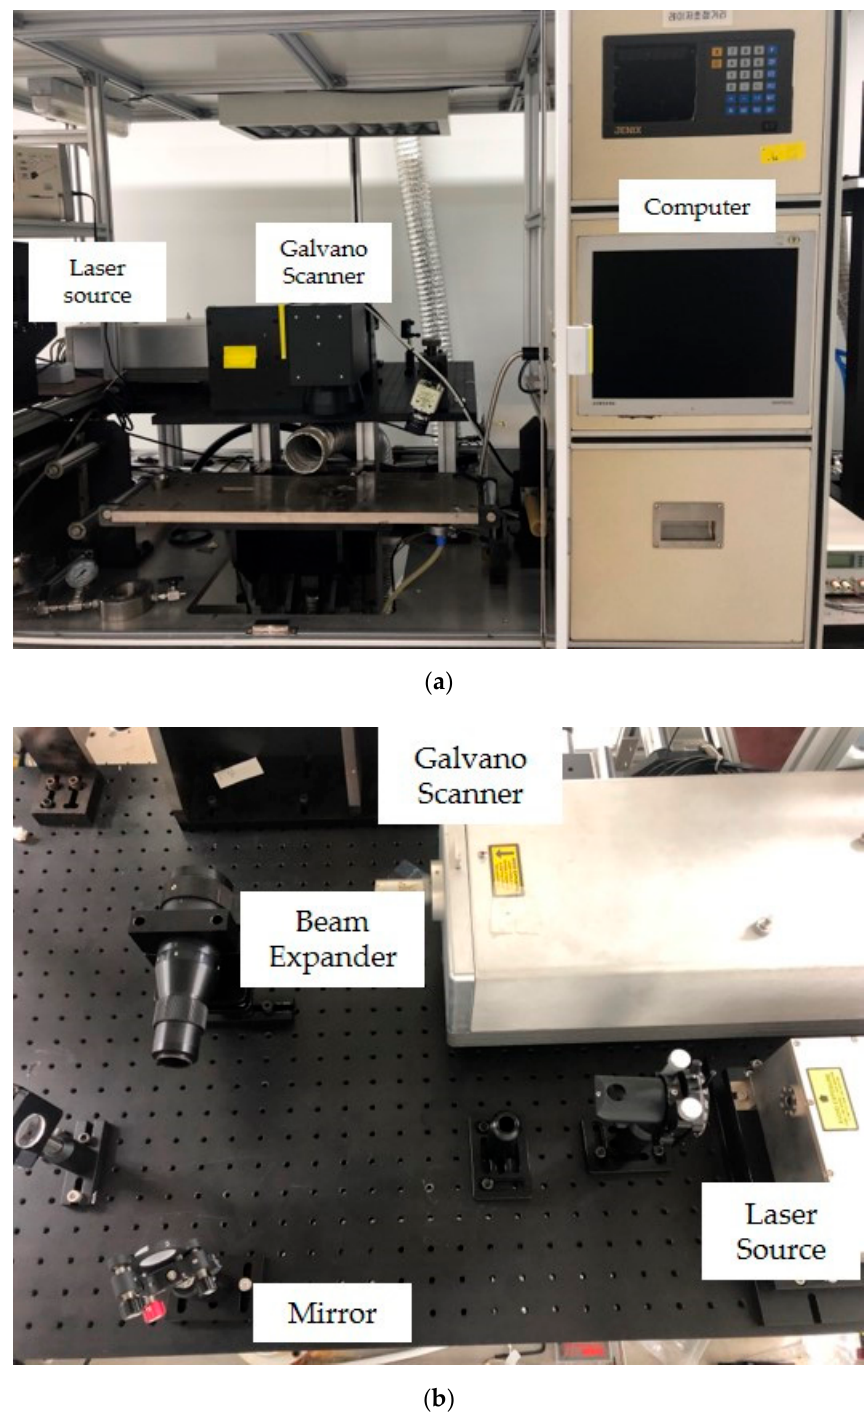
Figure 1. Laser system: ( a ) laser setup and ( b ) optical system.